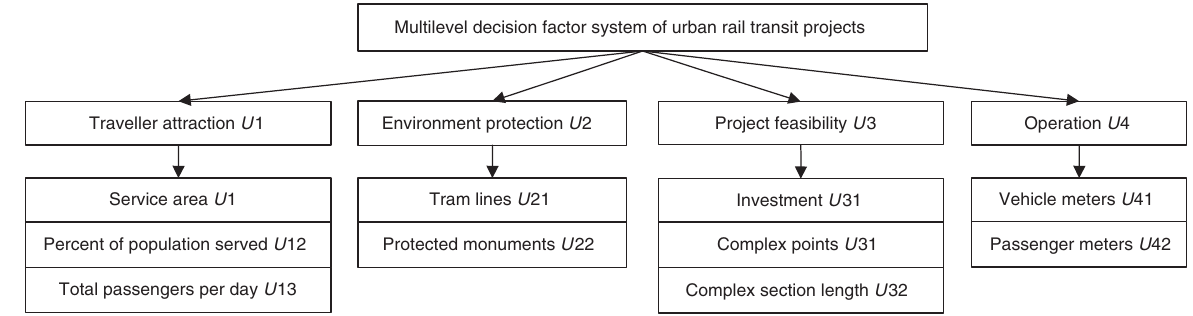
Fig. 4. Multilevel decision factor system of urban rail transit